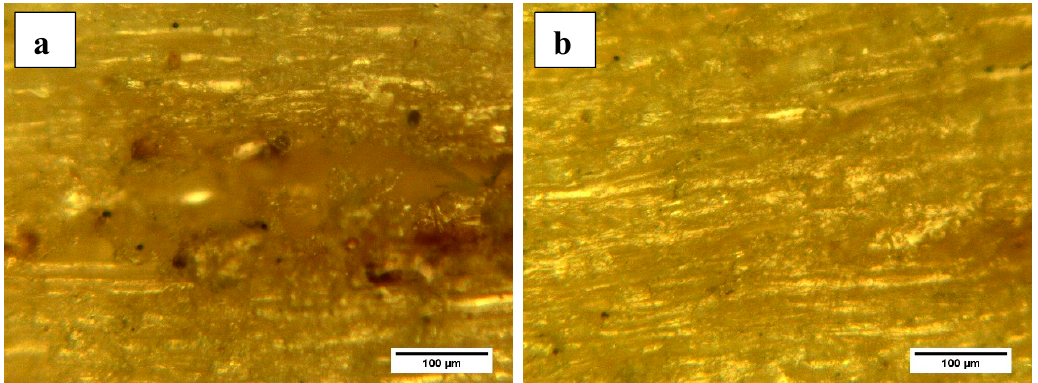
Figure 17. Microscopic appearance of the samples: ( a ) heterogeneity with associated porosity and ( b ) fiber arrangement.